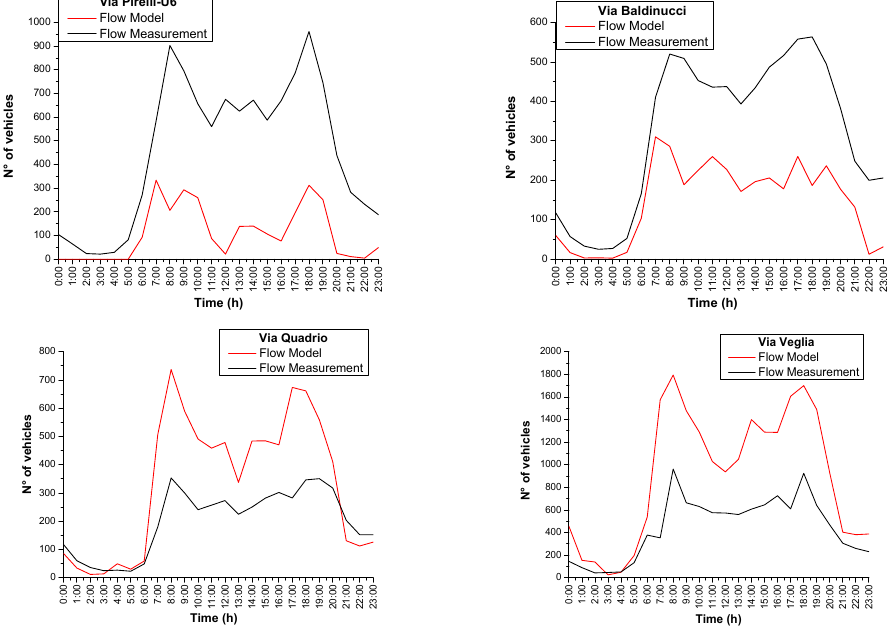
Figure 12. Comparison between hourly traffic flow (number of vehicles per hour) and traffic flow model calculations. Here, Via Pirelli ‐ U6 ( g 2 ), Via Baldinucci ( g 2 ), Via Quadrio ( g 4 ), Via Veglia ( g 5 ) are some selected locations corresponding to the position of monitoring stations.